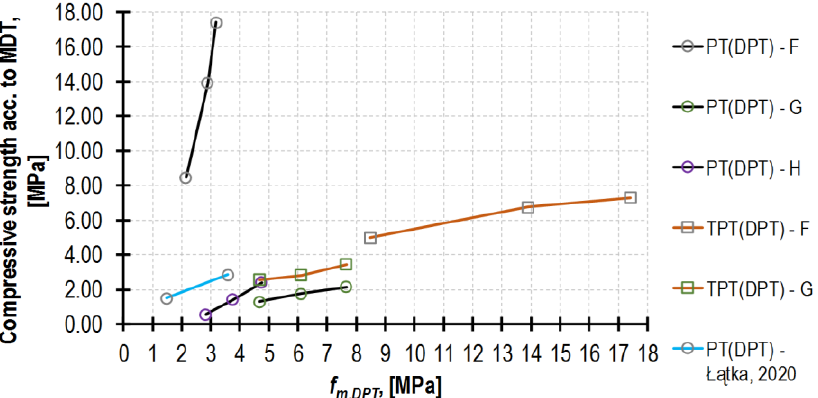
Figure 21. The correlations between the results of the MDTs and DPT. For comparison purposes, the correlation obtained from the author’s tests conducted on historical buildings [18] was marked with blue line.